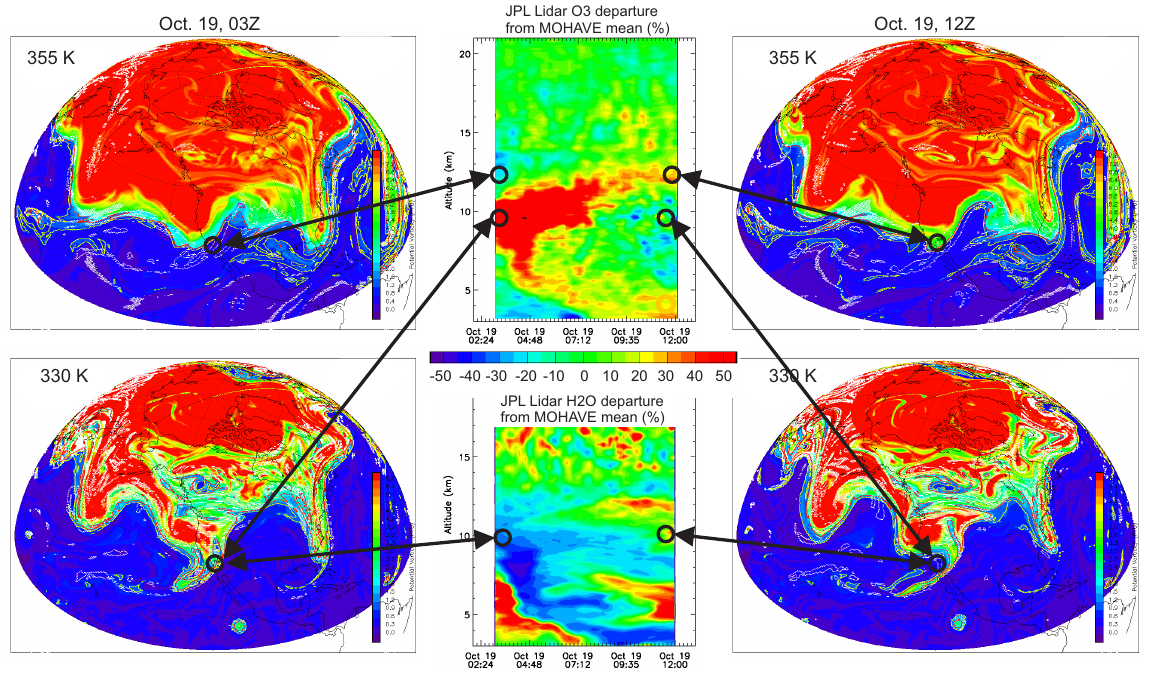
Fig. 8. A three-dimensional view of transport processes identified during MOHAVE-2009 by the JPL/TMF ozone differential absorption lidar and water vapor Raman lidar, and supported by the high-resolution PV advection model MIMOSA. The location of TMF, as well as the main atmospheric events identified by lidar and the model are denoted by open circles. See text for details.